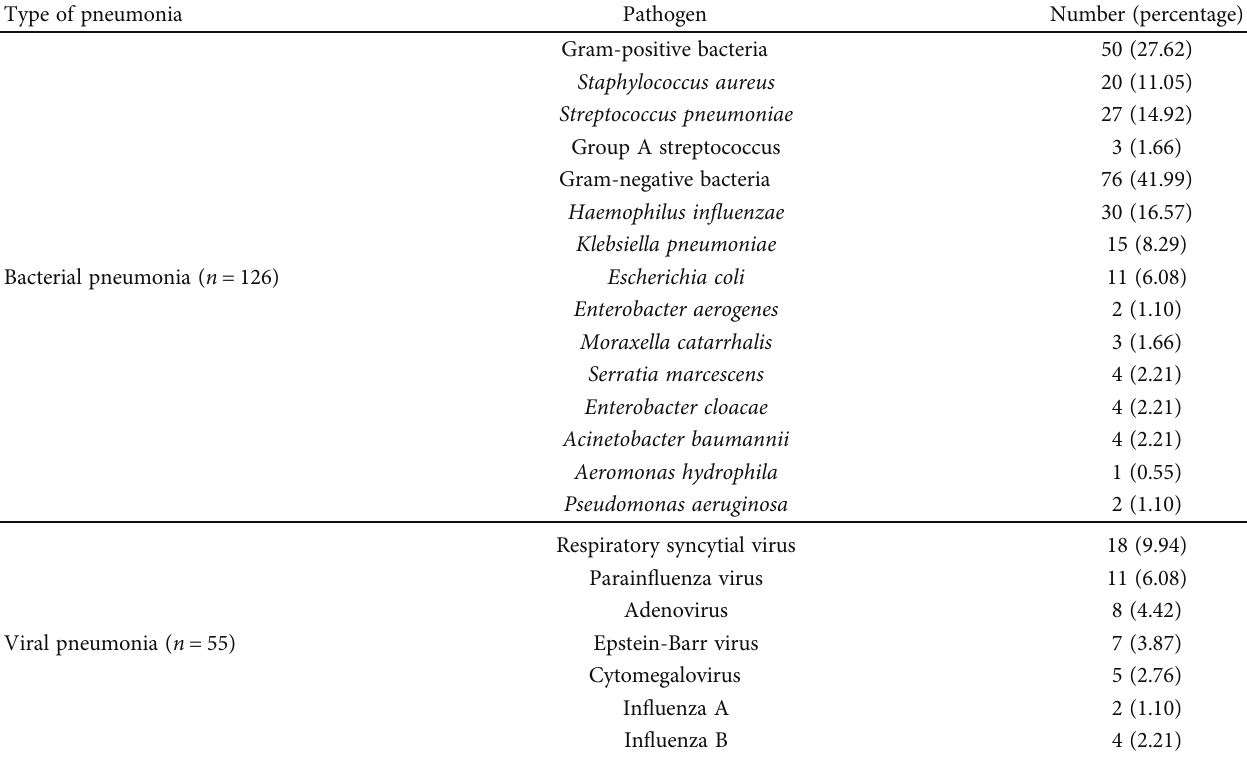
Table 2: Identities of pathogens in children with